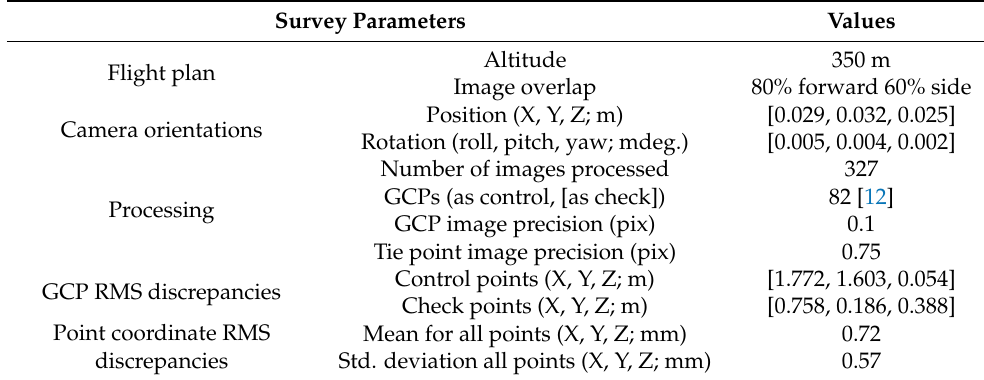
Table 2. Characteristics of the experimental area